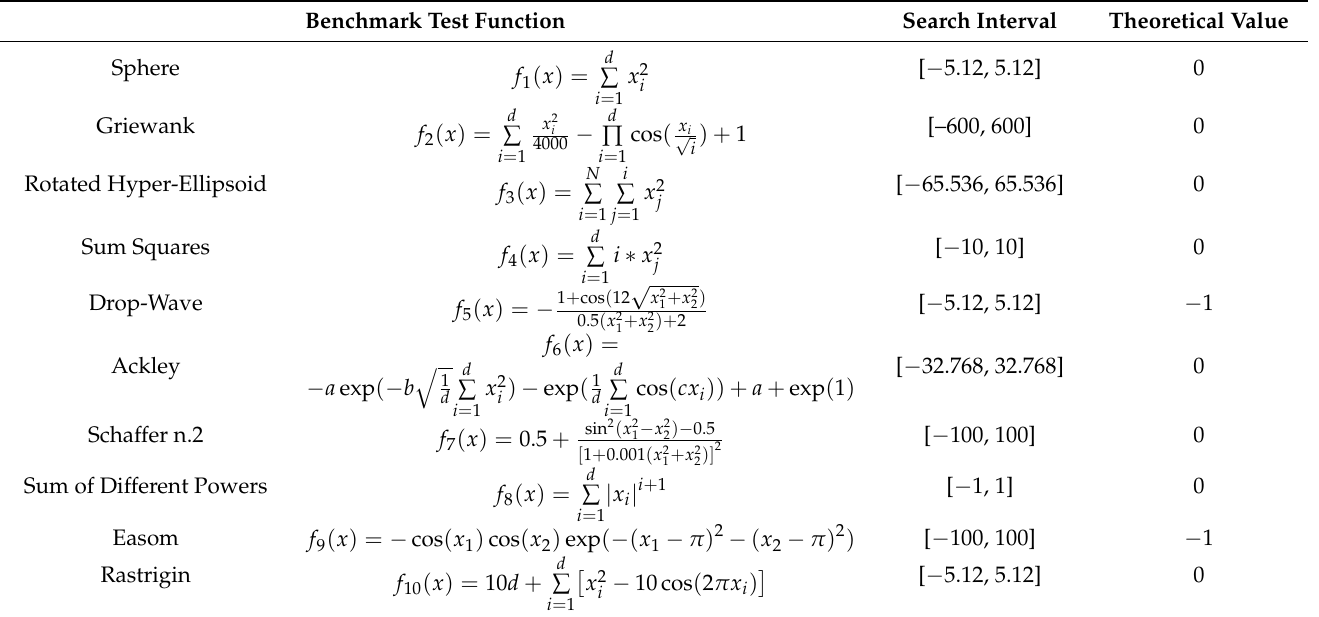
Table 1. Benchmark function.